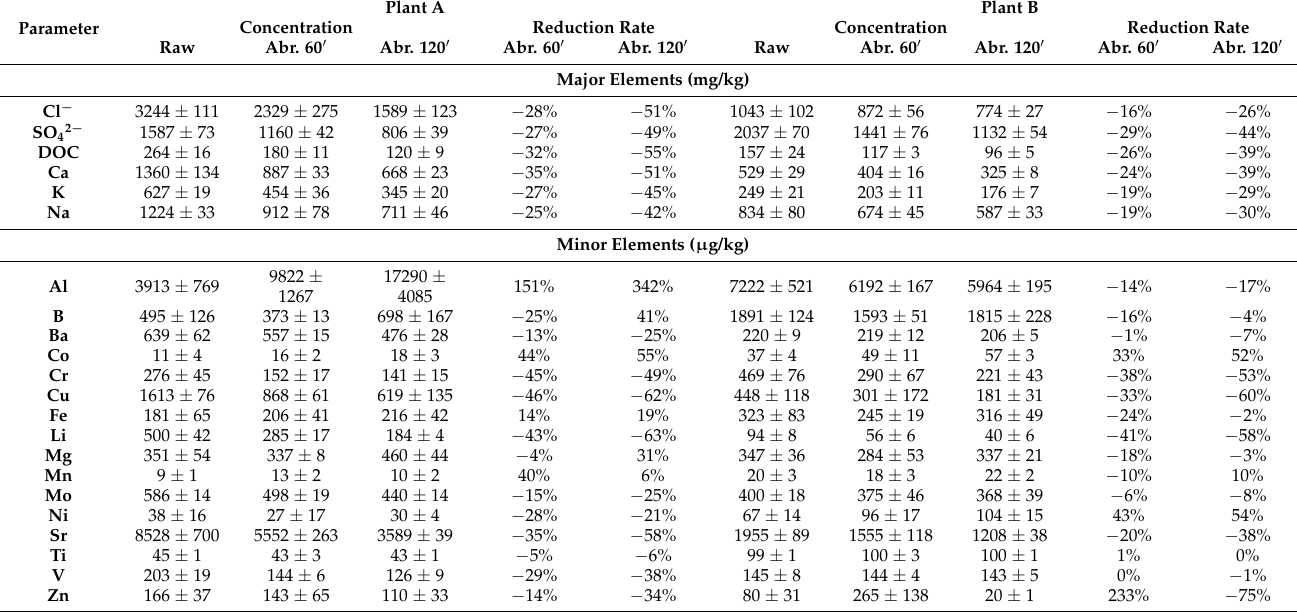
Table 4. Cumulative release for the elements considered at an L/S equal to 4 L/kg. (The results obtained from the concrete mixer are not shown). Reduction rates are calculated on the raw sample for increasing abrasion (Abr.)